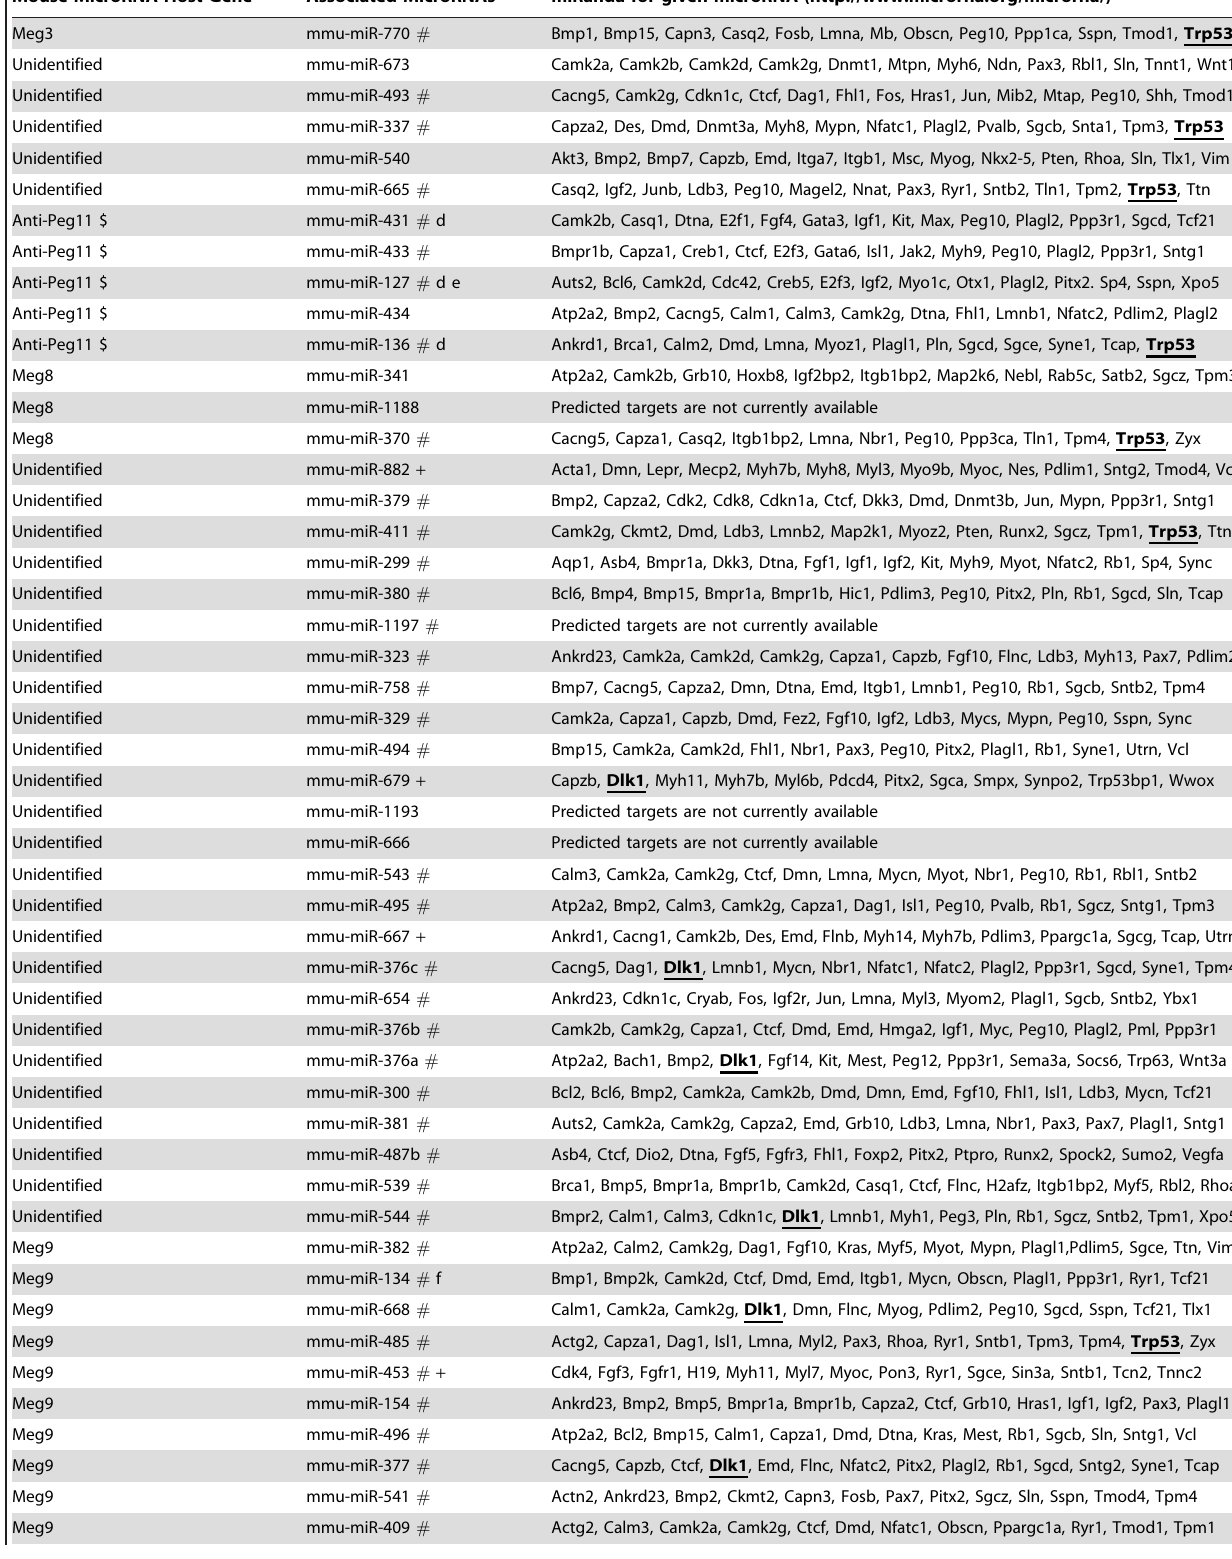
Mouse MicroRNA Host Gene Associated